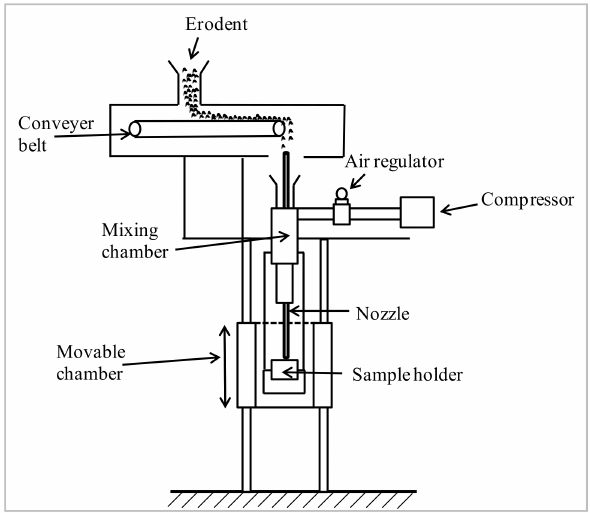
Figure 2. Schematic representation of erosion test